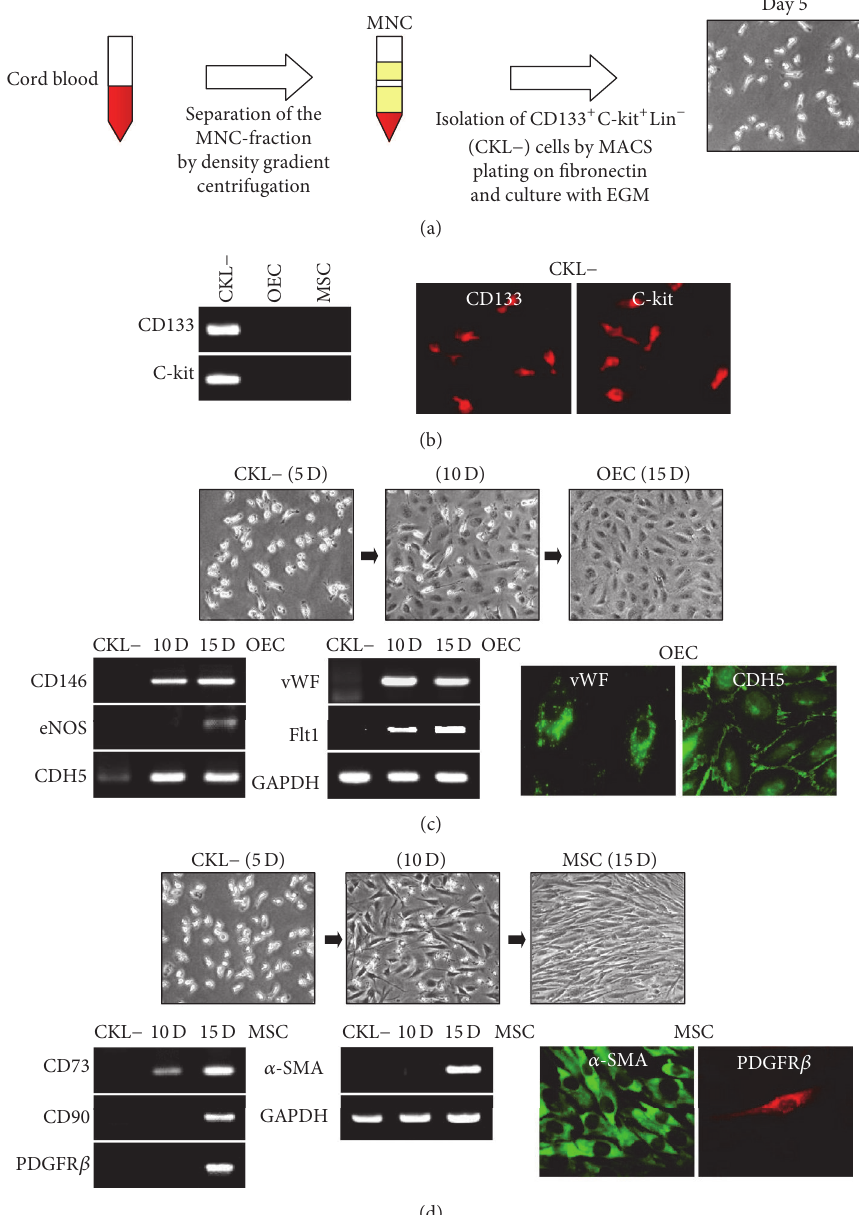
Figure 1: Isolation and characterization of CKL − cells from human umbilical cord blood. (a) CKL − cells were isolated by density gradient centrifugation over Biocoll for 30min at 400 × g, washed three times in PBS, and purified by positive selection with anti-CD133/C-kit/Lin − microbeads using a magnetic cell sorter device. (b) Total mRNA was isolated from CKL − cells, and gene expression was assessed by RT-PCR. CKL − cells were further characterized by immunofluorescent staining for CD133 and C-Kit. (c, d) CKL − cells differentiated into OECs and MSCs as confirmed by RT-PCR and immunofluorescent staining for OEC- and MSC-specific